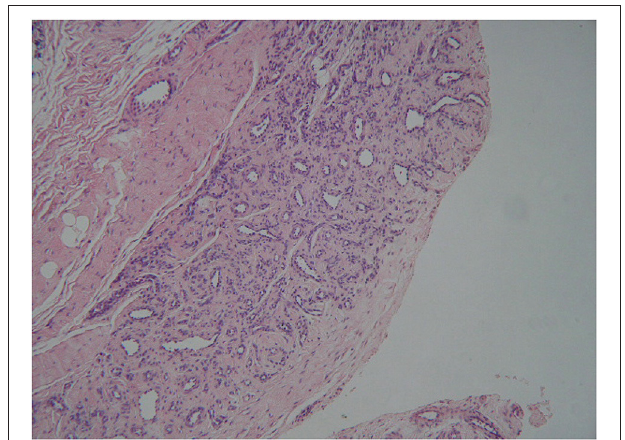
FIGURE 6 | Case 3: histology. Histological examination showing synovial proliferation and capillaries below, suggesting a capillary-type synovial haemangioma (haematoxylin and eosin stain, 40 ×